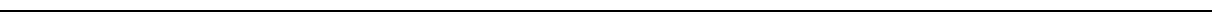
Fig. 4 Suppression of distant responses by a bar moving inside the receptive fi eld center. a Response raster of a single cell to a moving bar presented in and/or outside of its receptive fi eld center. Each dot is a single spike from the recorded cell. Each line corresponds to a different repetition of the same stimulus. (i) Bar moving inside the receptive fi eld center. (ii) Bar moving outside the receptive fi eld center. (iii) Both bars displayed together. Black ellipses indicate examples where the response to the distant bar is strongly suppressed by the stimulus inside the receptive fi eld center. b Suppression index for real cells (data, blue) and due to noise (control, gray); see text and Methods section for details. Data are represented as mean ± SEM ( n = 13 cells). The three stars indicate that the p -value of a two-sample t -test was lower than 0.001. c , d Spatio-temporal distribution of the ON-subunit weights for the second stage of the subunit model, averaged over all cells. c Combined bar stimulus. d A single-distant bar stimulus. Blue and red ellipses show the reduction of the weights in the surround in the presence of central bar motion. Since we focus on distant weights here (see text), central weights are saturated in these panels. e , f Same as c , d for OFF-subunits. g ON subunit weight difference between the single-distant bar stimulus and the combined bar stimulus, averaged between 0 and 200 ms time lag. The shades represent SEM. h Same as g for OFF-subunit weights. i Schematic showing how cells switch the mode of computation when a bar is displayed within their receptive fi eld